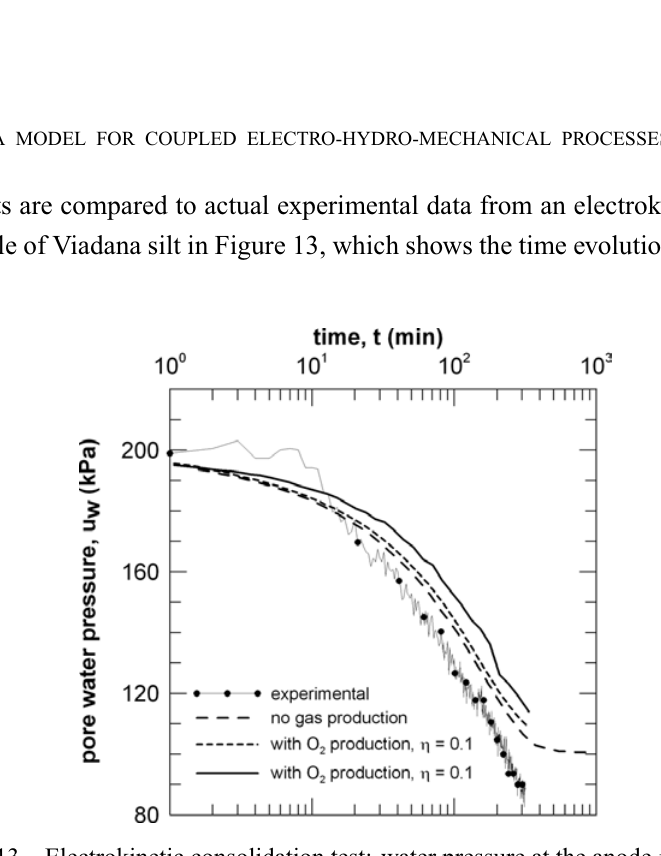
Fig. 13 – Electrokinetic consolidation test: water pressure at the anode vs. time.